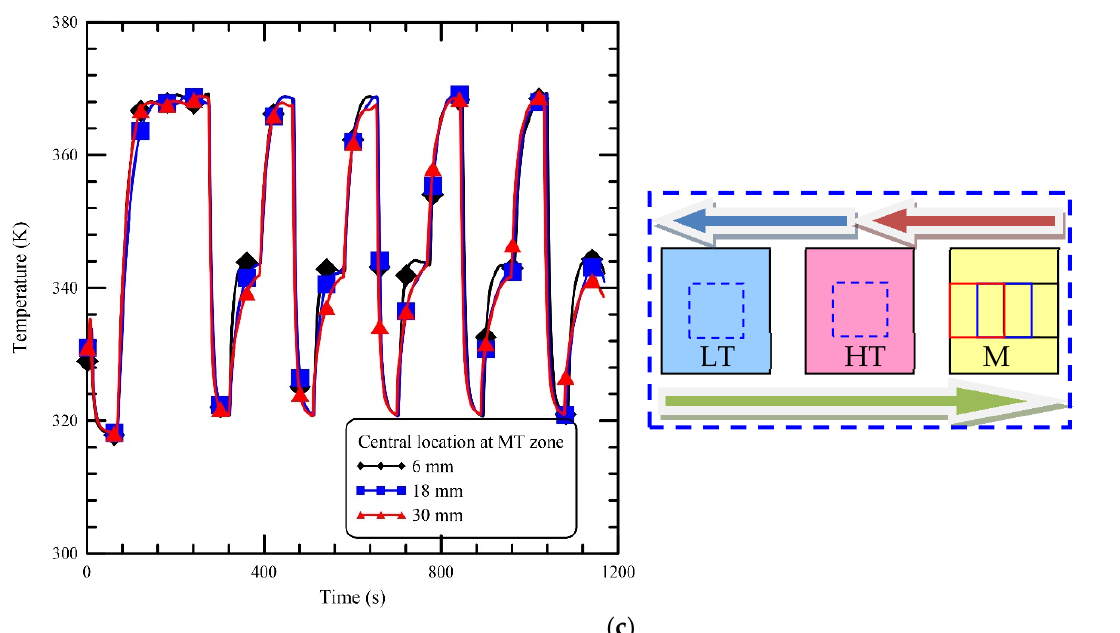
Figure 5. The influence of various chamber locations on the reaction chamber temperatures. ( a ) The temperature profiles of the chamber staying at the locations of the HT zone of 6 mm, 18 mm, and 30 mm. ( b ) The temperature profiles of the chamber staying at the locations of the LT zone of 6 mm, 18 mm, and 30 mm. ( c ) The temperature profiles of the chamber staying at the locations of the MT zone of 6 mm, 18 mm, and 30 mm.